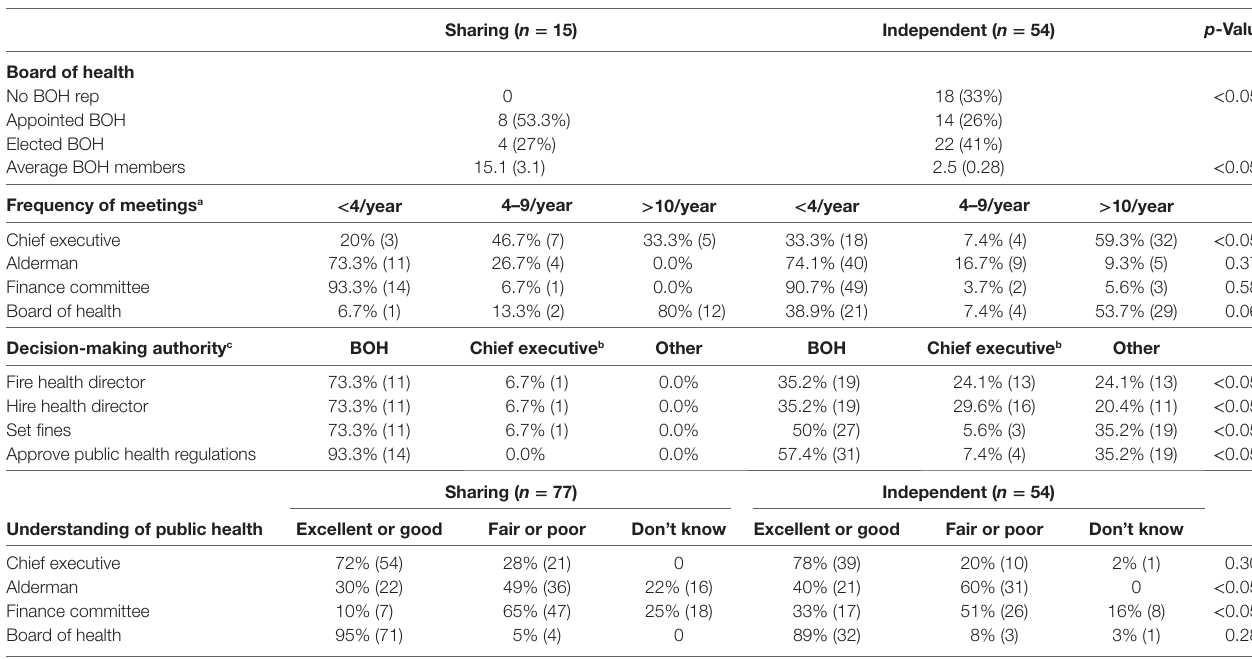
TaBle 5 | Board of health and government